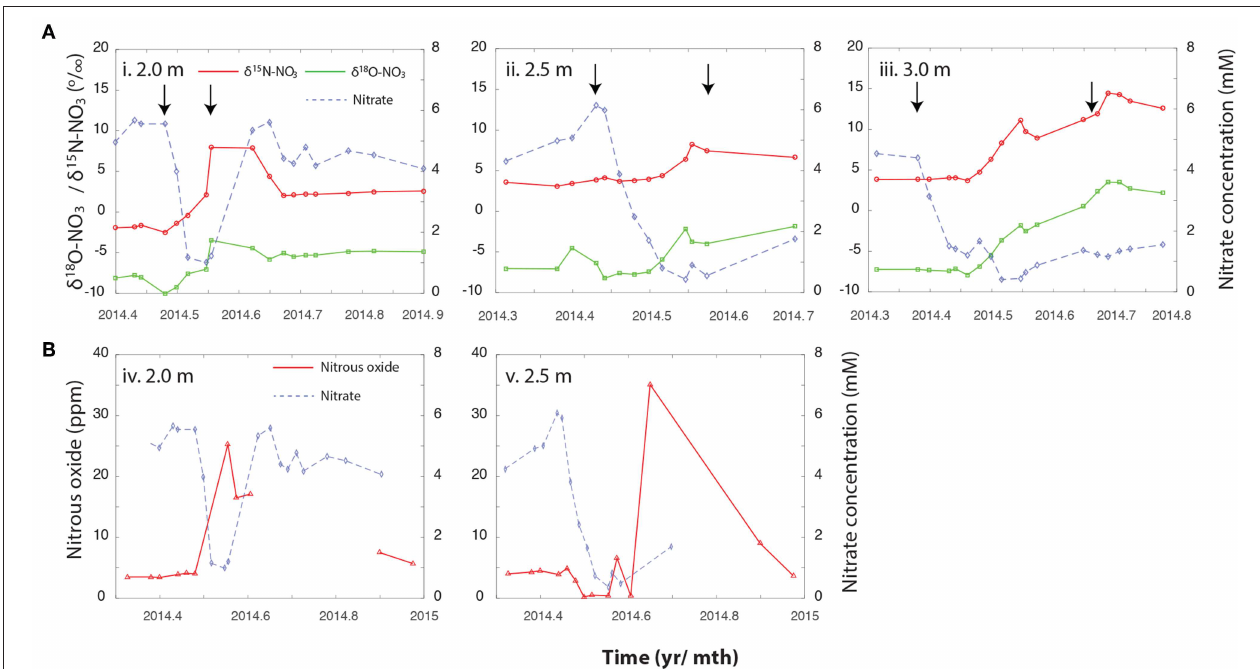
and δ 18 O NO over the Spring and Summer of 2014 at (i) 2 m, (ii) 2.5 m, and (iii) 3 m FIGURE 2 | (A) Changes in NO 3 − concentrations, and the associated δ 15 N NO 3 3 bsd. (B) Trajectory of N 2 O trace gas measurements against NO 3 − concentrations across the same depth profile, (iv) 2 m, and (v) 2.5 m. These measurements were not taken as frequently than the NO 3 − isotopic measurements but encompass the period depicted in the corresponding panels above. Arrows indicate the period during which the water table saturated the relevant depth. Please note that the x-axis is different between the upper panel (A) and lower panel (B) .